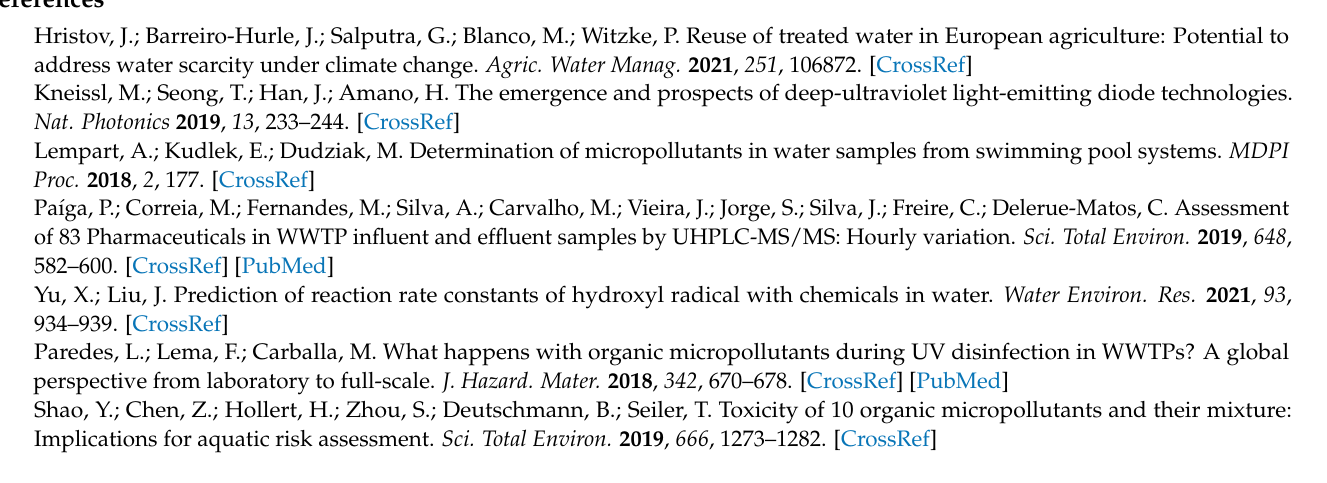
Figure S3: Degradation profiles for the individual degradation experiments; Figure S4: ANOVA results for categorical DoE by Design Expert 12 software; Figure S5: ANOVA results for surface response DoE by Design Expert 12 software; Table S1: Tap water composition in Zagreb,